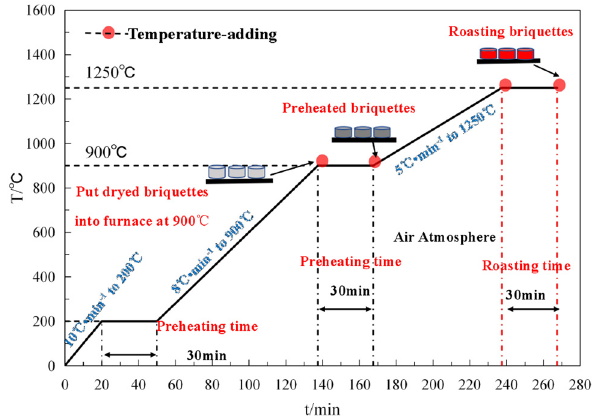
Figure 1: Experimental conditions diagram.